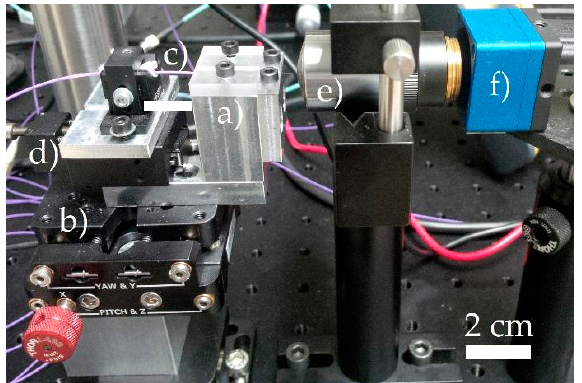
Figure 4. Photo of the optical measurement setup: the chip under test is inserted in a custom designed sample holder ( a ) fastened on a 3D translation stage ( b ). IR light is delivered via a multimode fibre ( c ) whose position can be adjusted by a 1D translation stage ( d ). Imaging optic ( e ) is a microscope objective (50×, NA = 0.8). All measured data are registered by a CMOS beam profiler (CinCam CMOS Nano, CINOGY Technologies GmbH) ( f